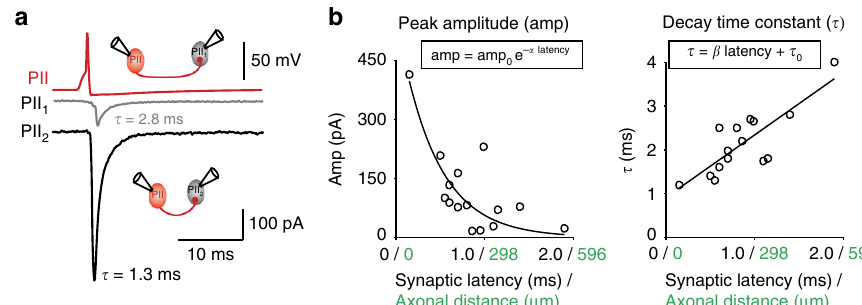
Fig. 2 Distance-dependent inhibition at PII – PII synapses. a Two representative paired PII – PII whole-cell recordings in dentate gyrus slices 36 . Top, presynaptic PII action potential (AP). Bottom, average uIPSCs recorded in two postsynaptic PIIs (gray and black). b Peak amplitude (amp, left) and decay time constants ( τ , right) of N = 15 PII – PII connections plotted against the respective synaptic latency and the calculated axonal distance (distance = 0.29 mmms − 1 * latency + 0.01mm) 26 . Decay time constants were measured by biexponential fi ts and are given as amplitude-weighted τ 26 . Lines represent exponential and linear fi t functions with DD coef fi cients α and β (equations above). Spearman ’ s correlation analysis: amp, p = 0.01; τ , p